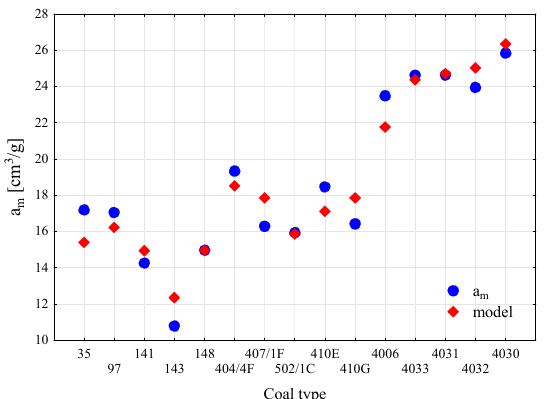
Figure 9. Value comparison between the maximum sorption capacity a m and the created regression model (Equation (10)).